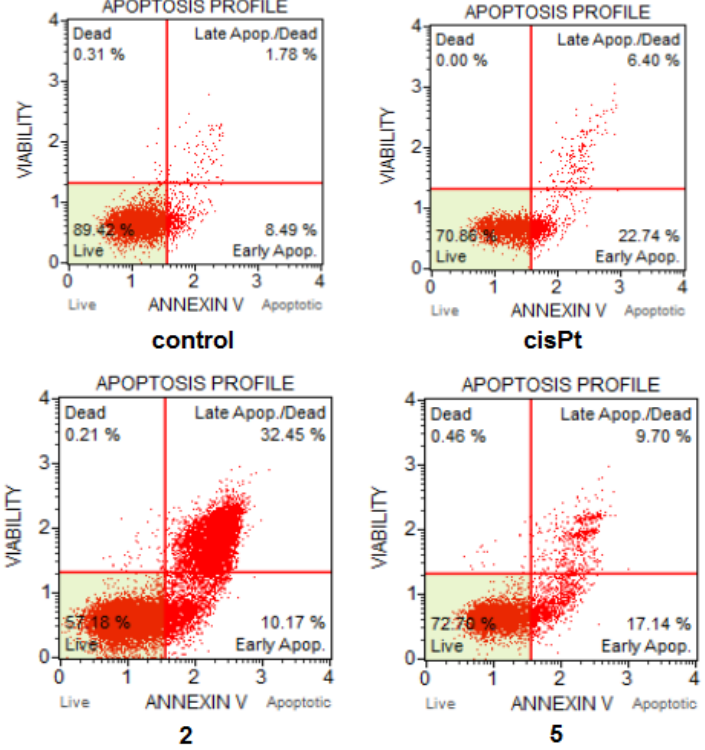
Figure 5. HCT-116 apoptotic profile after treatment with cisplatin and compounds 2 , 5 after 24 h. Concentration of compounds 2 ∙ IC 50 ( μ M).